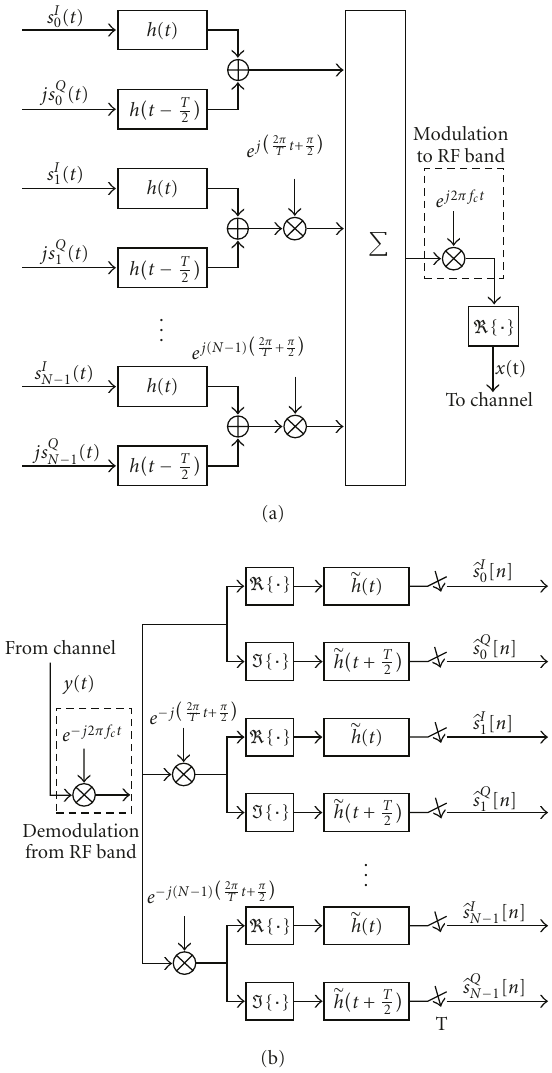
Figure 3: Block diagram of a SMT